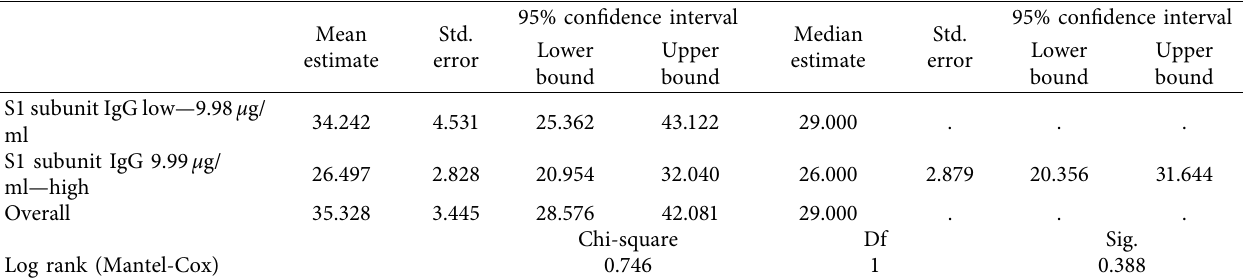
Table 5: Means and medians for survival time for the S1 subunit